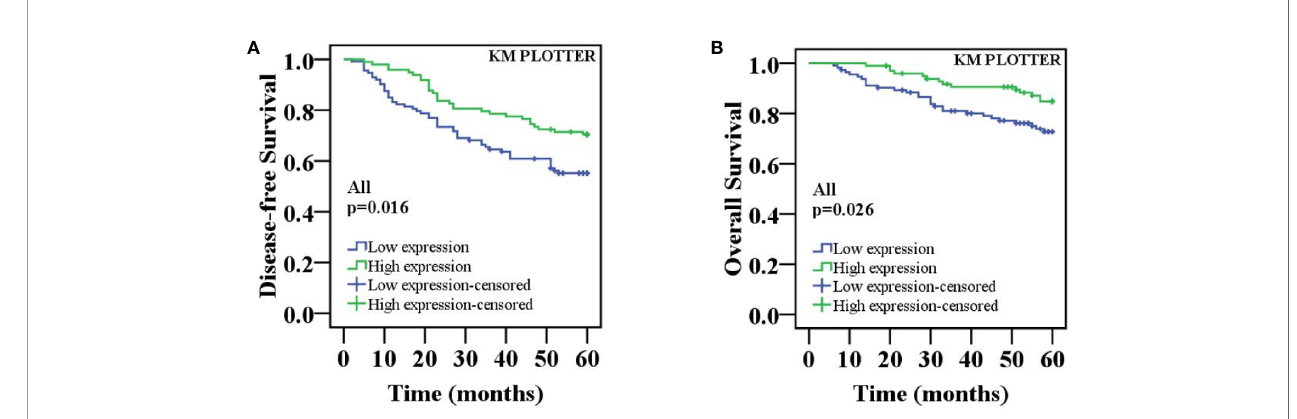
FIGURE 5 | K-M survival curves for the correlation of the nuclear ING3 expression in breast cancer patients. (A) Patients with low expression of nuclear ING3 staining had a signi fi cantly worse 5-DFS than those with high expression of ING3 staining in 211 cases of breast cancer. (B) A similar conclusion for 5-OS.